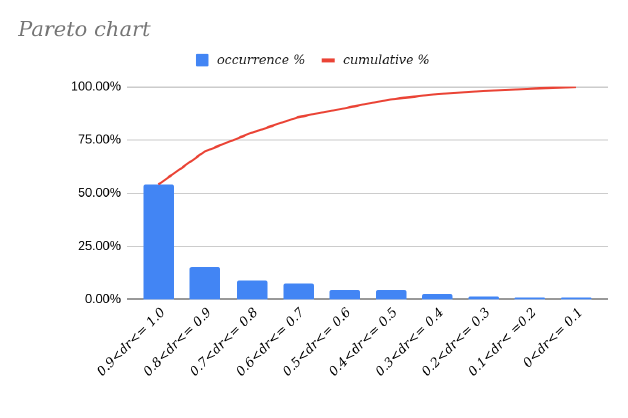
Figure 8. Pareto chart of the data in Table